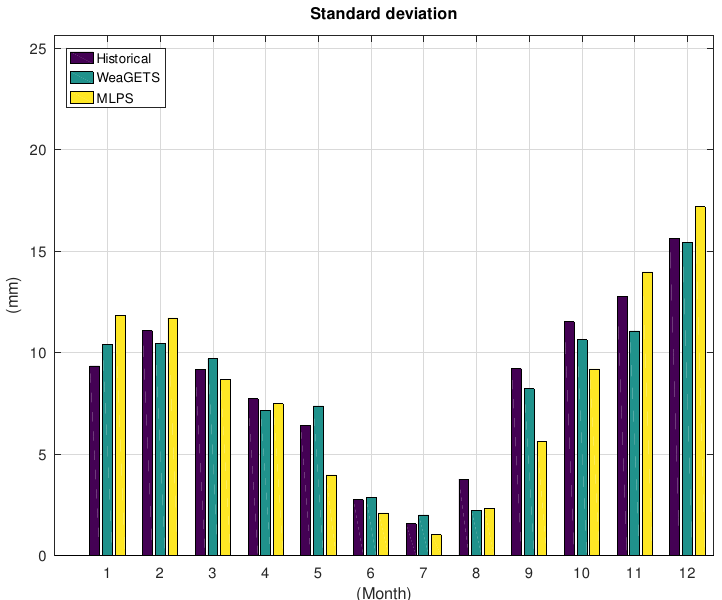
Figure 10. Monthly standard deviation of the synthetic (WeaGETS and MLPS) and historical time series of the Gibraltar weather